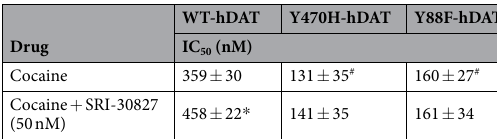
Table 4. Effects of SRI-30827 on cocaine-induced inhibition of [ 3 H]DA uptake in WT and mutated hDAT. Data are presented as mean ± S.E.M. of 5–6 independent experiments performed in duplicate. * p < 0.05 compared with the value of cocaine within WT-hDAT (Student’s unpaired t test). # p < 0.05 compared with the value of cocaine from WT-hDAT (Student’s unpaired t